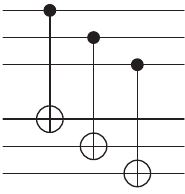
FIG. 7. Transversal implementation of the logical CNOT . For clarity, the number of cat qubits per repetition cat qubit is n ¼ 3 . Here, the three upper lines represent the control repetition cat qubit, and the three bottom ones represent the target one.